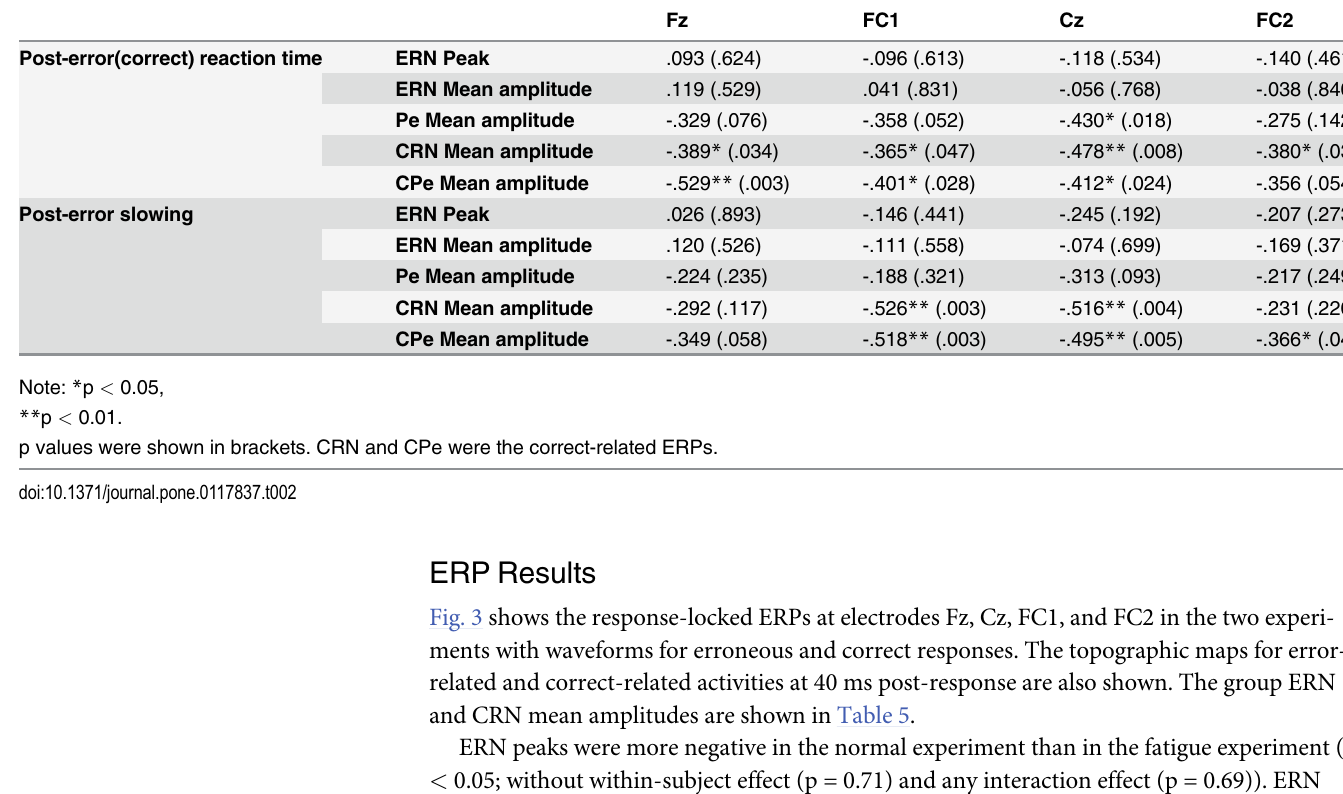
Table 2. Spearman correlations of post-error (correct) RT, post-error slowing, and error-related ERPs.